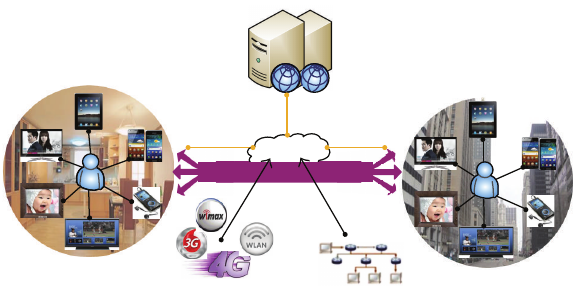
Figure 1: N-Screen (multiscreen) based content delivery